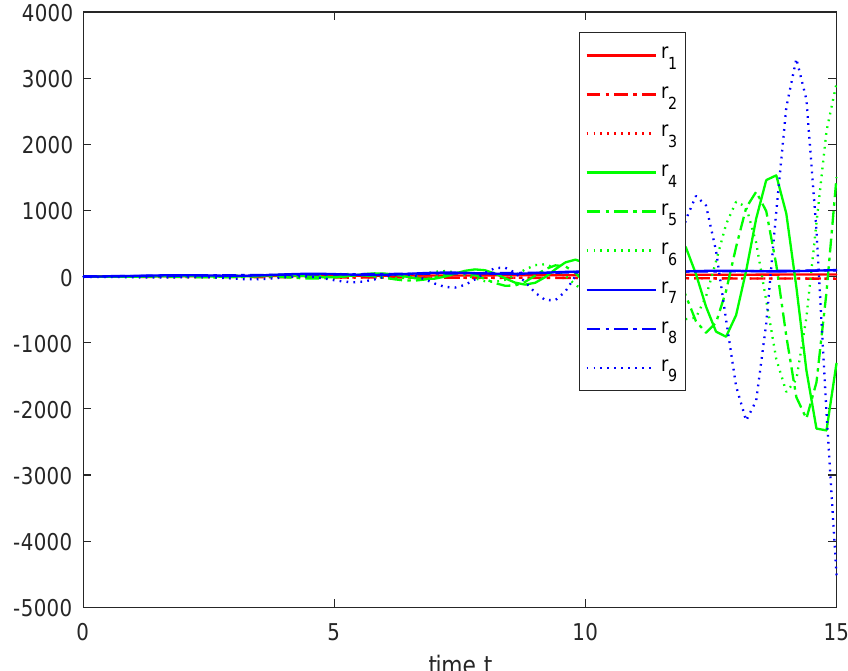
Figure 4. The time evolution trajectories of r i ( t ) , i = 1,2, · · · ,9, with h = 0.2 in Example 1.